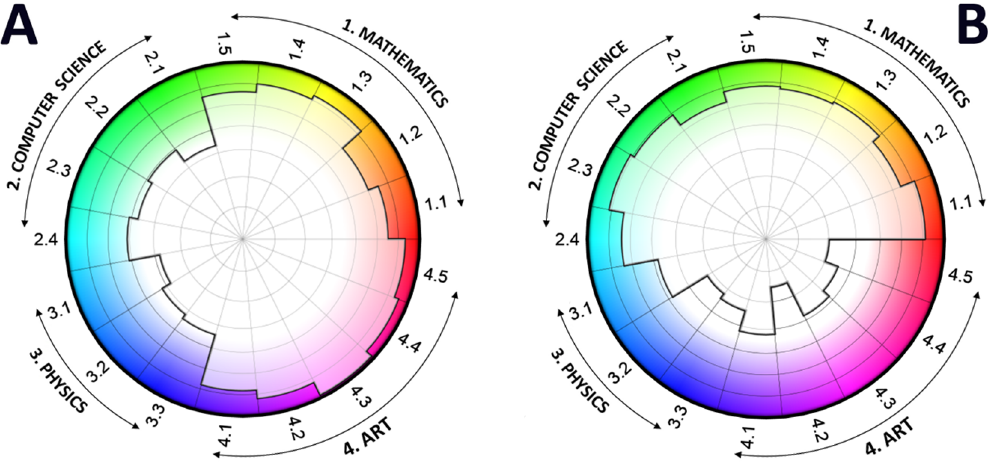
Figure 4. Two examples of radar diagrams representing competence